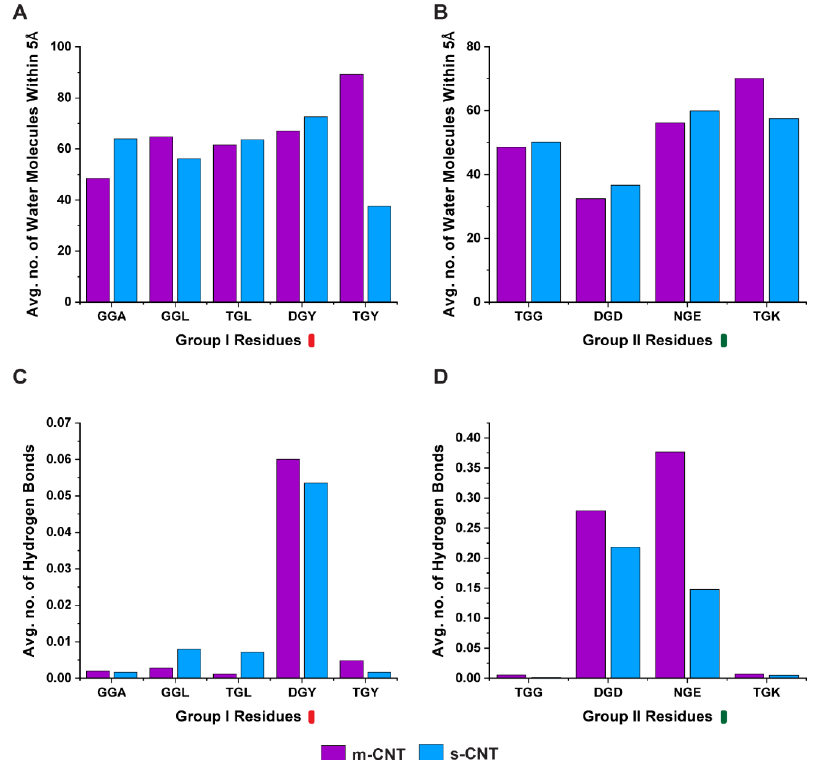
Figure 6. Average number of water molecules within 5Å of the tripeptide for ( A ) Group I and ( B ) Group II combinations. Average number of hydrogen bonds formed by the intermediary water molecules between tripeptide and CNT for ( C ) Group I and ( D ) Group II combinations.